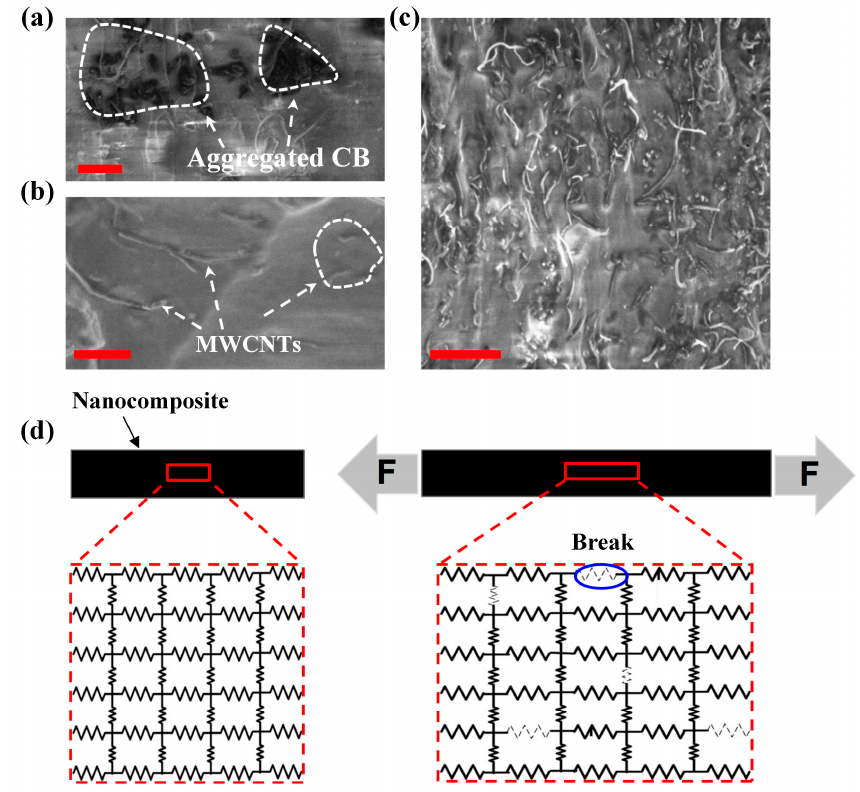
Figure 5. Nanocomposite mechanism working as a strain sensor. ( a ) SEM image of 1.75 wt % CB distributed in PDMS, the scale bar is 100 nm; ( b ) SEM image of 3 wt % MWCNT distributed in PDMS, the scale bar is 3 µ m; ( c ) SEM image of hybrid fillers CB (1.75 wt %) and MWCNT (3 wt %) distributed in PDMS, the scale bar is 5 µ m; ( d ) Schematic diagram showing the resistance change of nanocomposite under tensile strain.